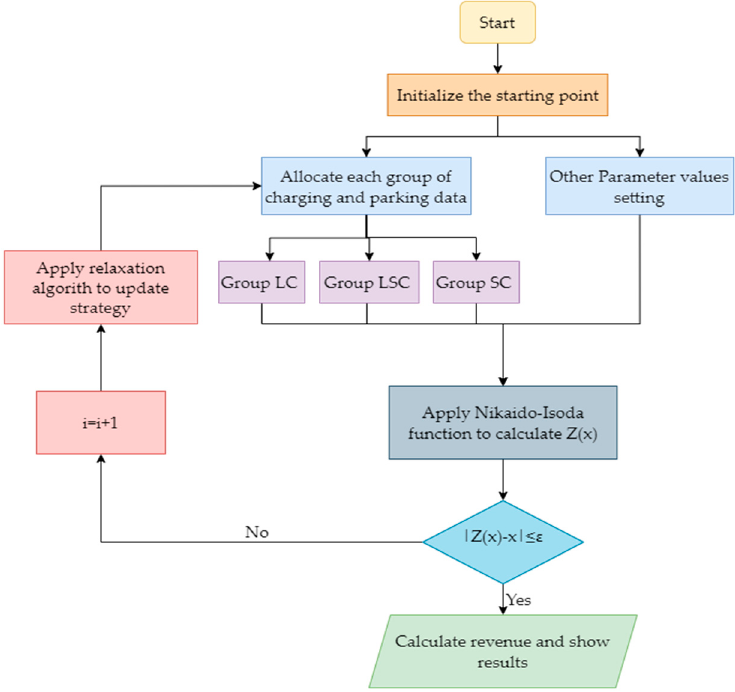
Figure 2. Flowchart of the proposed game-theoretic algorithm.